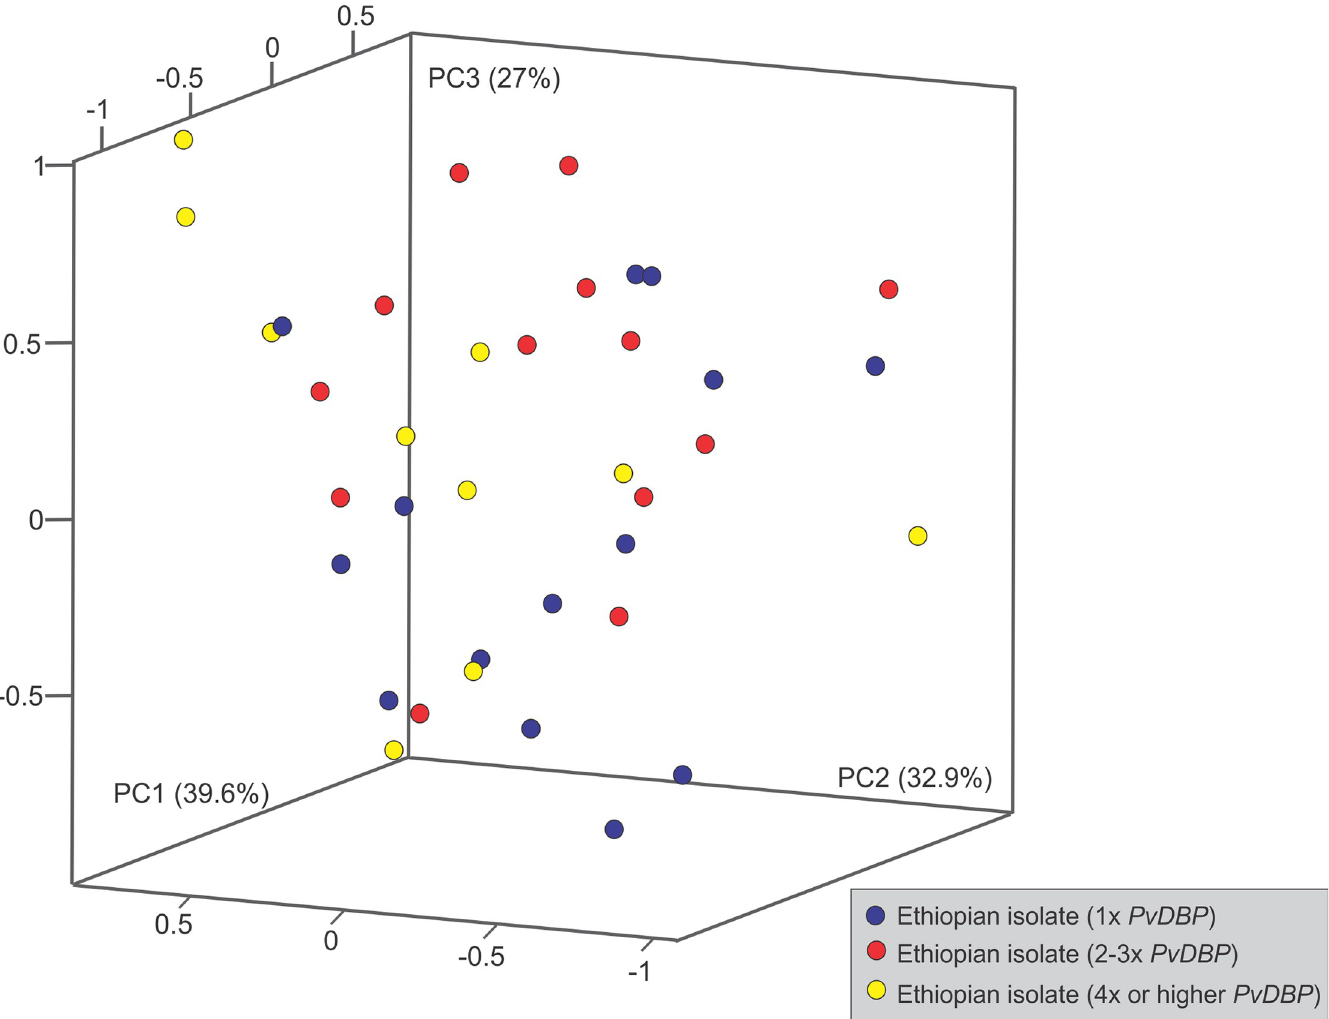
Fig 5. Scatter plot based on principle component analyses showing variation in malaria symptoms among the P . vivax patients. PvDBP copy number of P . vivax observed in each of the patient samples was indicated by different color circles. The first three axes represented 99.5% of the total variation from 12 malaria symptoms. No clear cluster was observed among samples with single or multiple PvDBP copies, suggesting that malaria symptoms of these patients did not relate to PvDBP copy number. Malaria symptom data are presented in S3